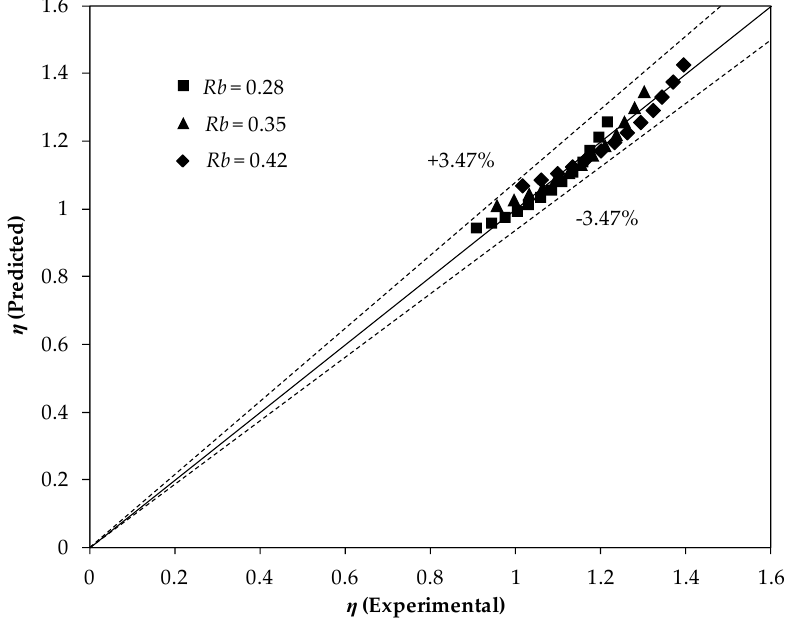
Figure 11. Comparison between the experimental ƞ with predicted ƞ .